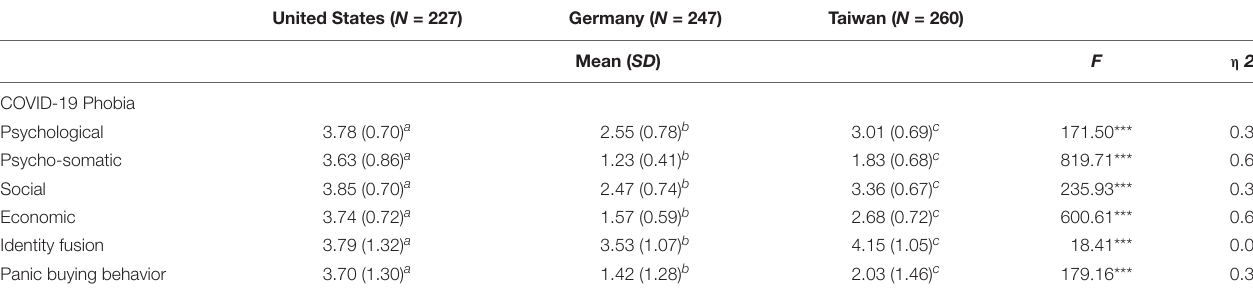
TABLE 3 | One-way ANOVA tests on each of the study variables across the three countries. United States ( N = 227)